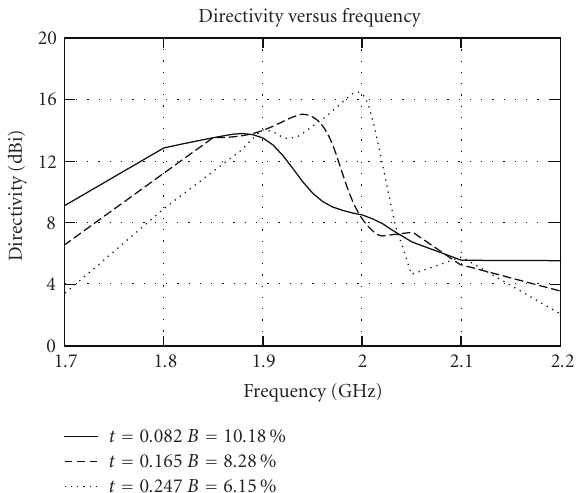
Figure 10: Directivity evolution for the three cases.